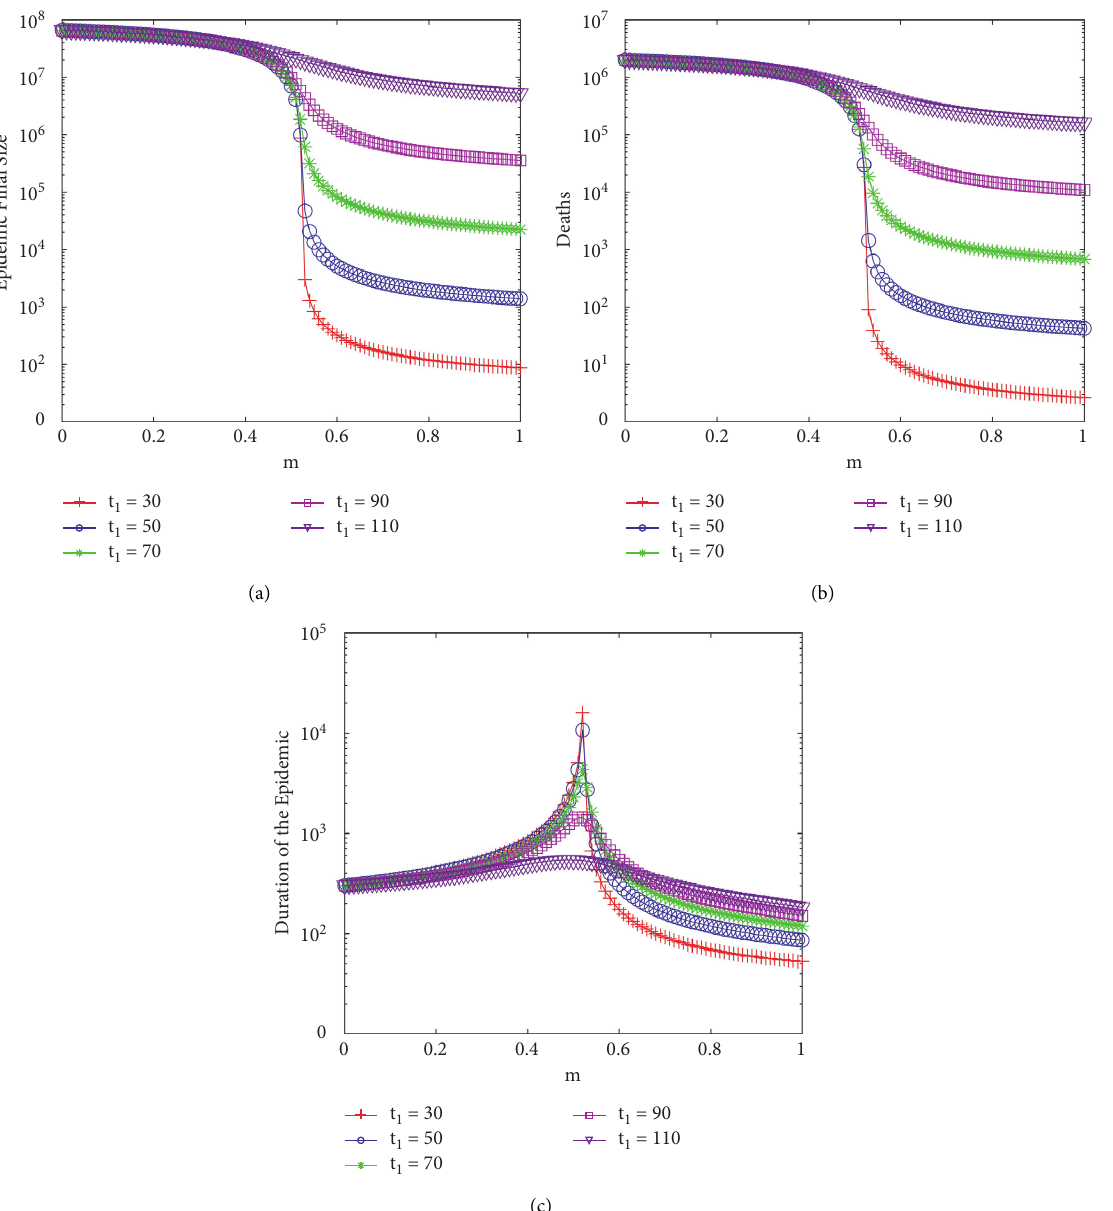
Figure 4: Diagnosis rate ] � 0 . 2. When the control measures are taken at different times, the (a) epidemic final size, (b) the number of deaths, and (c) the duration of the epidemic vary with the measures